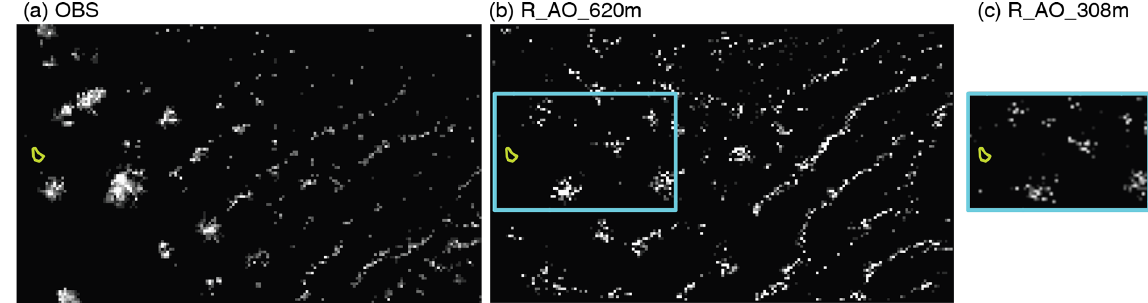
Figure 15. Snapshot of liquid water path on 2 February 2020 at 13:00UTC from (a) observations, (b) R_AO_620m, and (c) R_AO_308m. Observations are from the Pathfinder ATMOSpheres (PATMOS) derived from GOES (grid spacing of